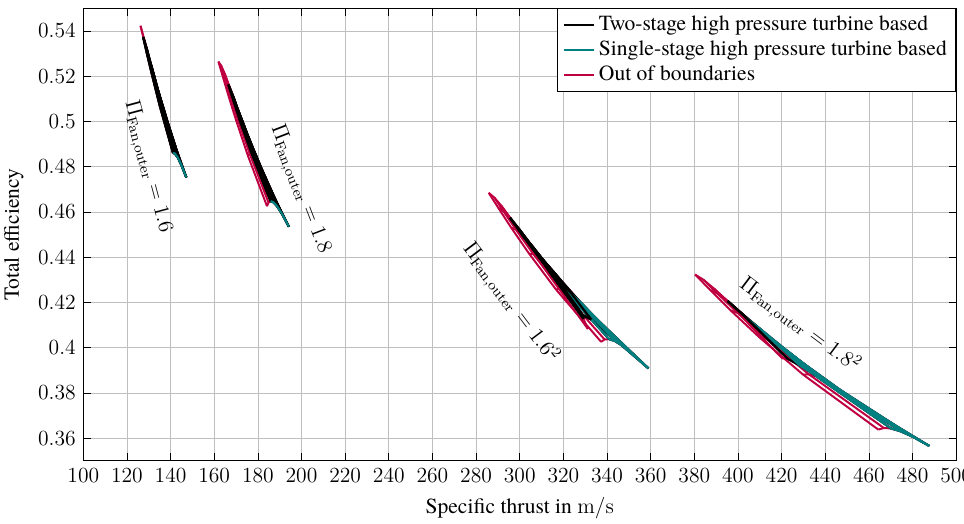
Figure 7. Cycle design trades with technology constraints and separation of engine